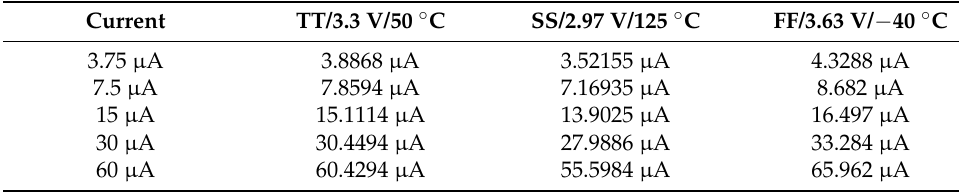
Table 6. Summary of bias circuit current post-simulation